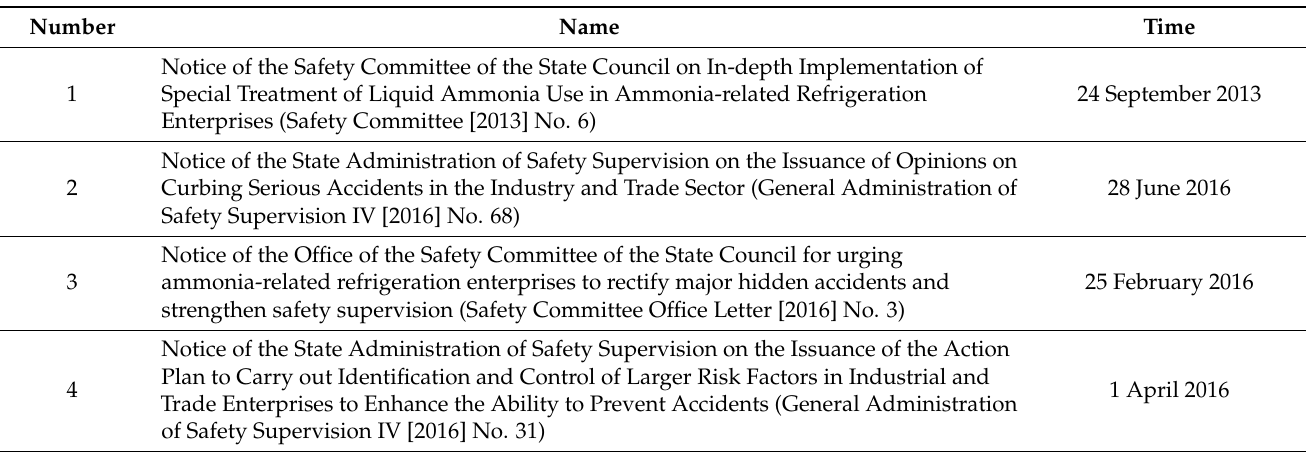
Table 6. Safety management policy related to ammonia